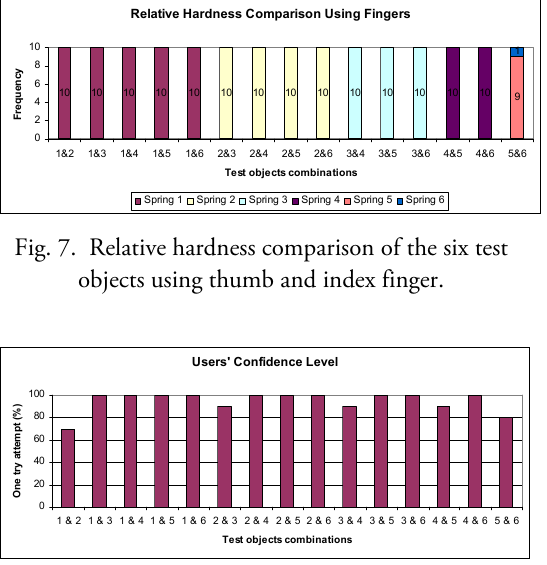
Fig. 8. Users’ confidence in comparing the test object combinations using thumb and index